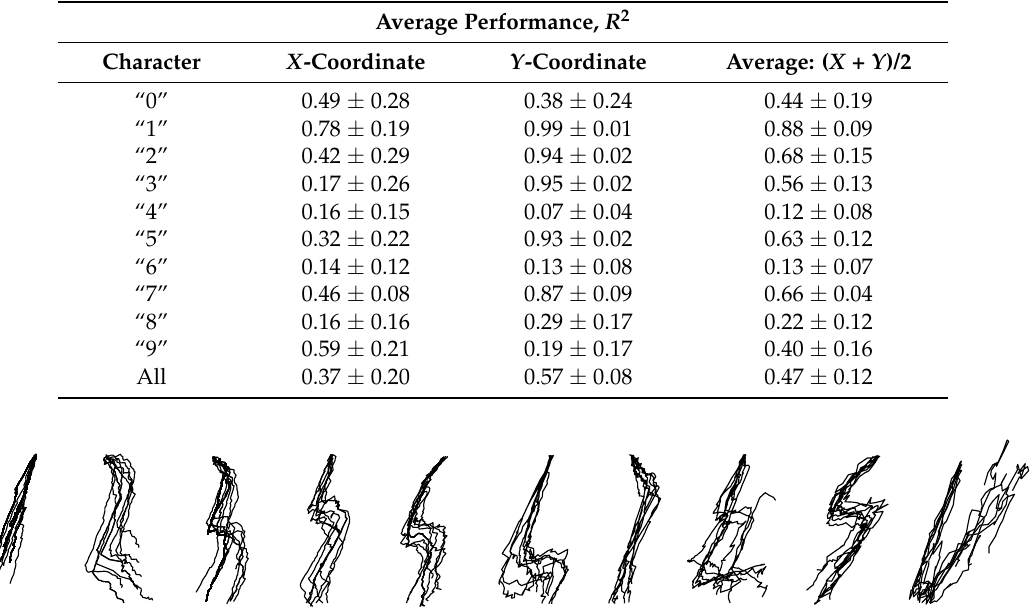
Table 11. Within-group reconstruction performance by the GEP: the average accuracy of each numeric character across the five subjects.